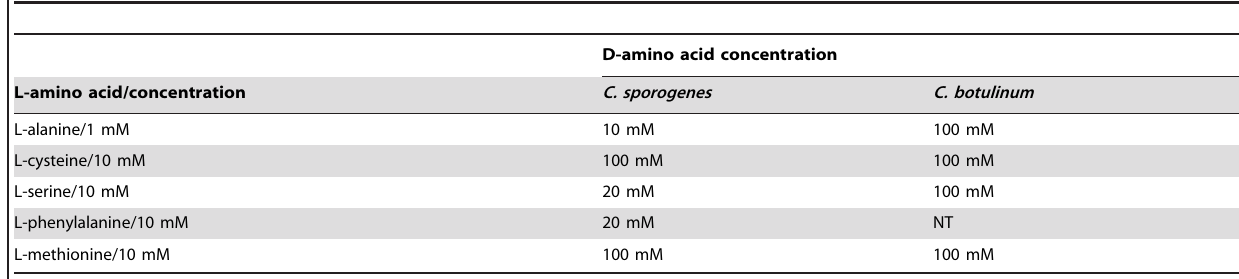
Table 1. Minimum D-amino acid concentration required to prevent* germination by its equivalent L-amino acid.